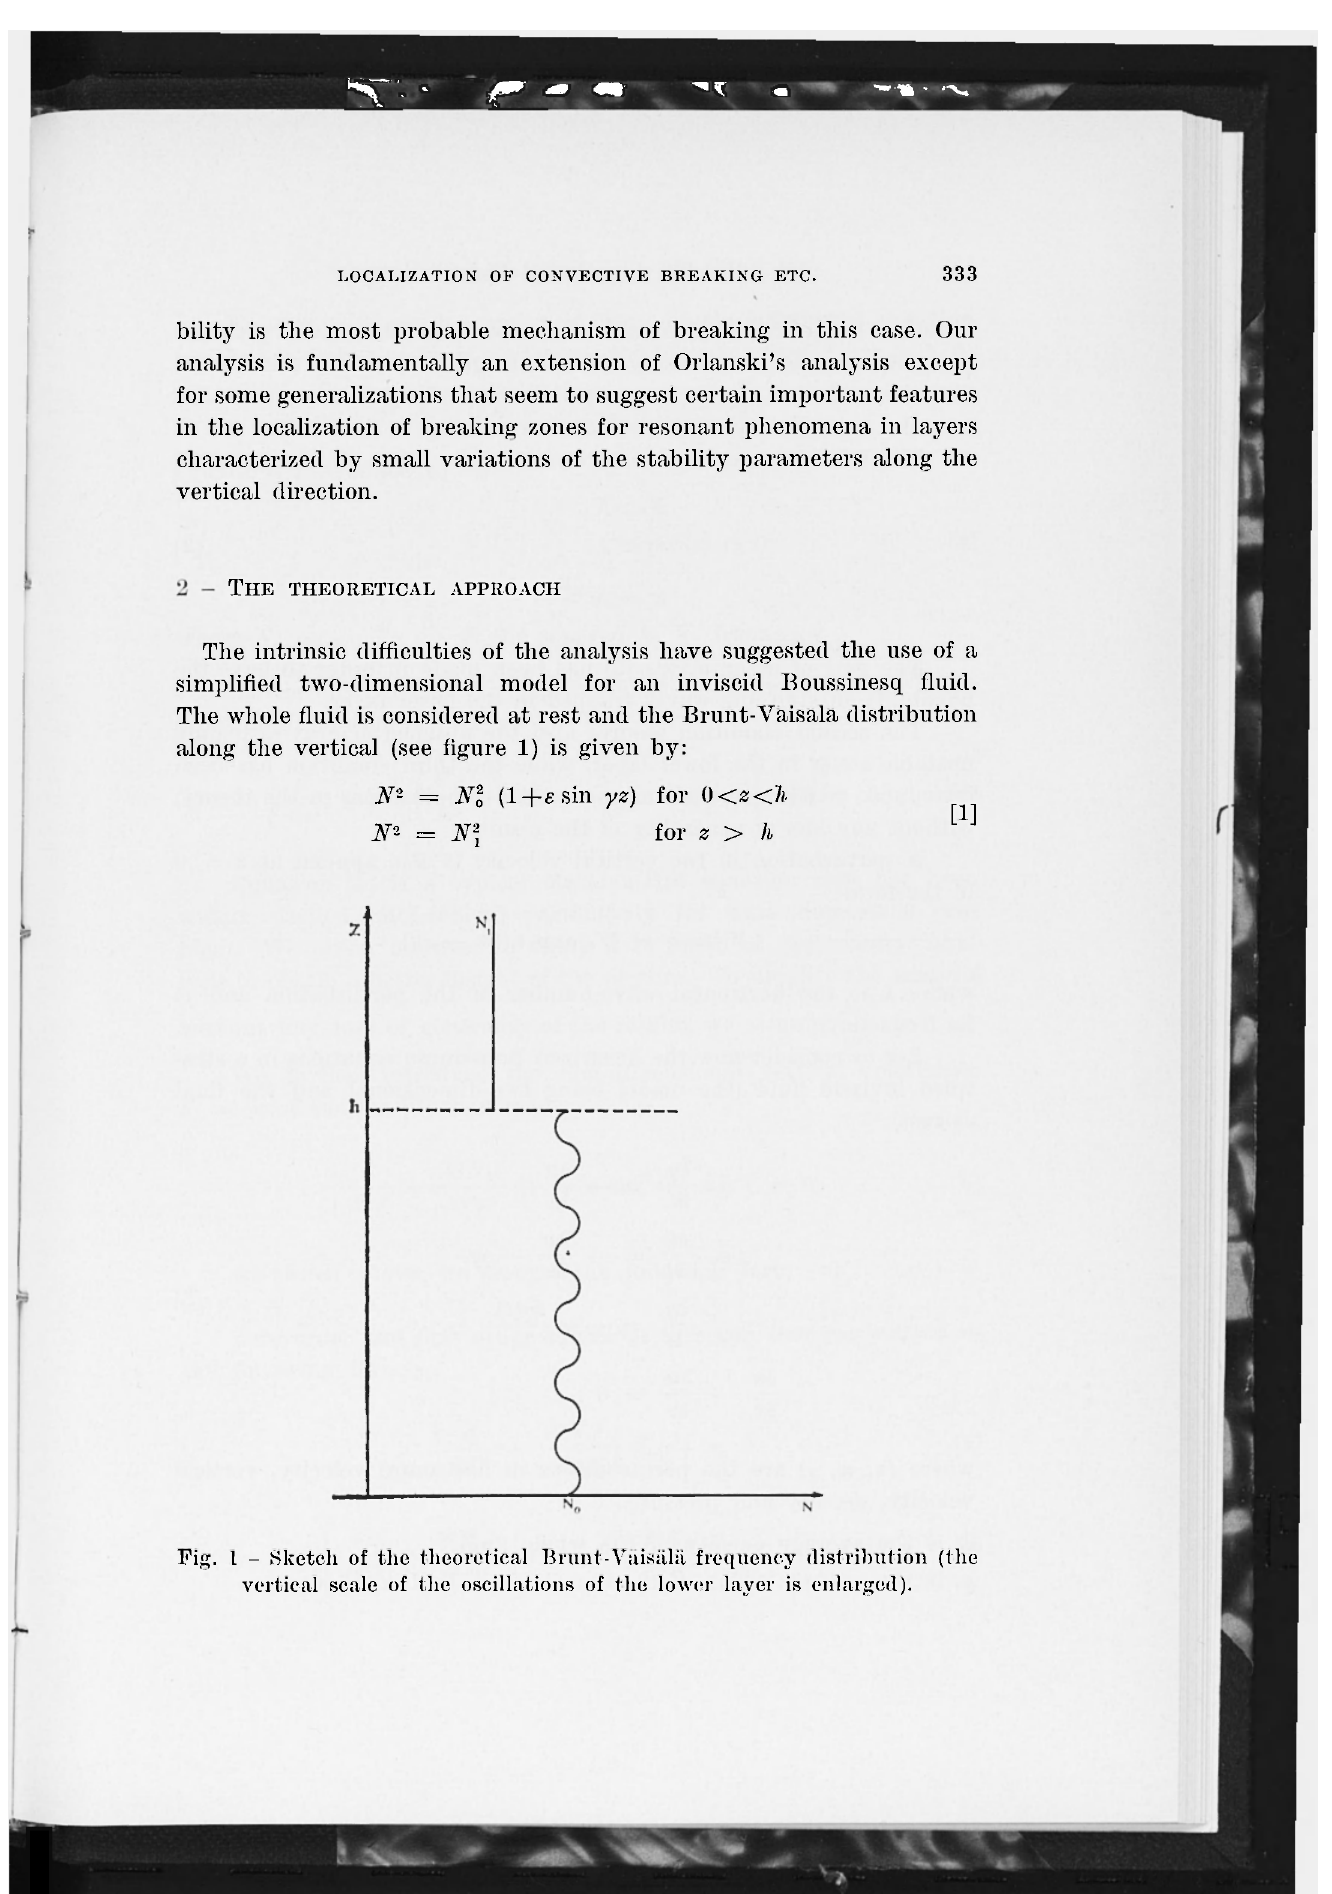
Fig. 1 - Sketch of the theoretical Brunt-Vaisâlâ frequency distribution (the vertical scale of the oscillations of the lower layer is